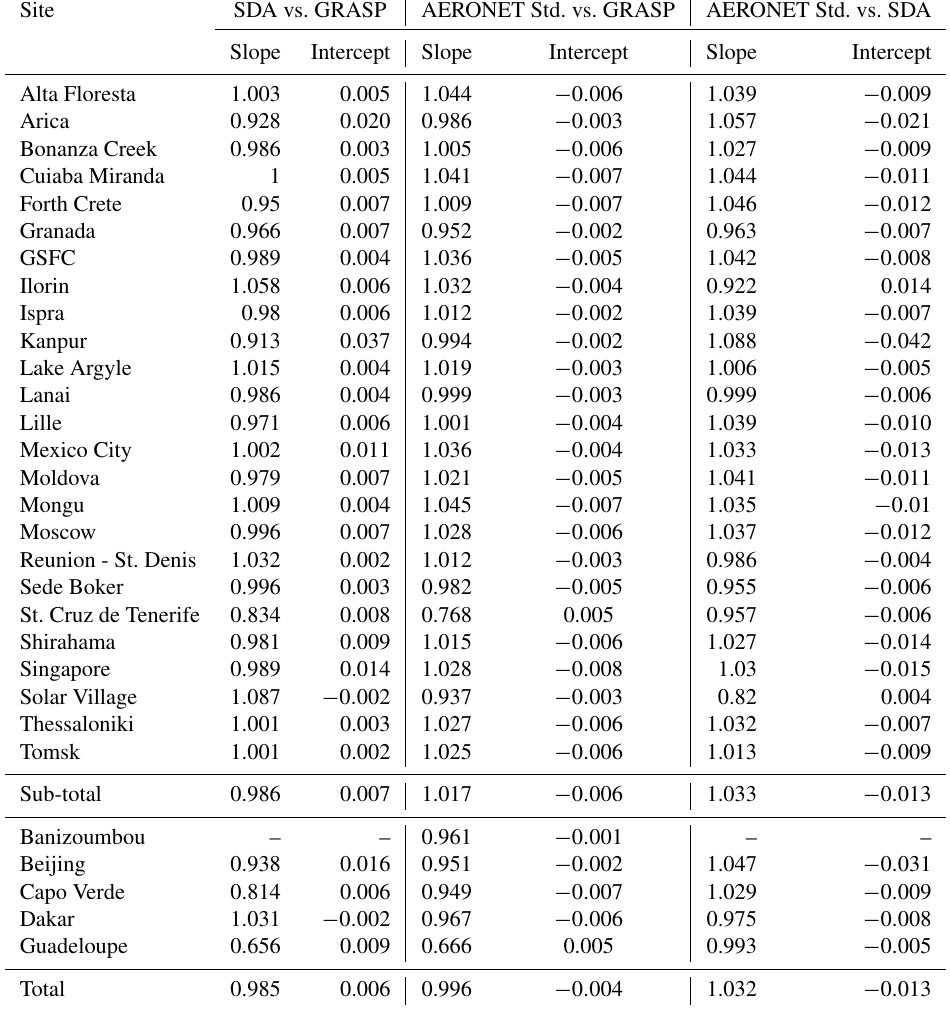
Table 5. Continuation of Table 4, which describes the comparisons of τ f ( 500 ) . Here, we represent the slopes and the intercepts obtained by the linear regressions between the τ f ( 500 ) values retrieved by the three different algorithms (AERONET, GRASP-AOD and